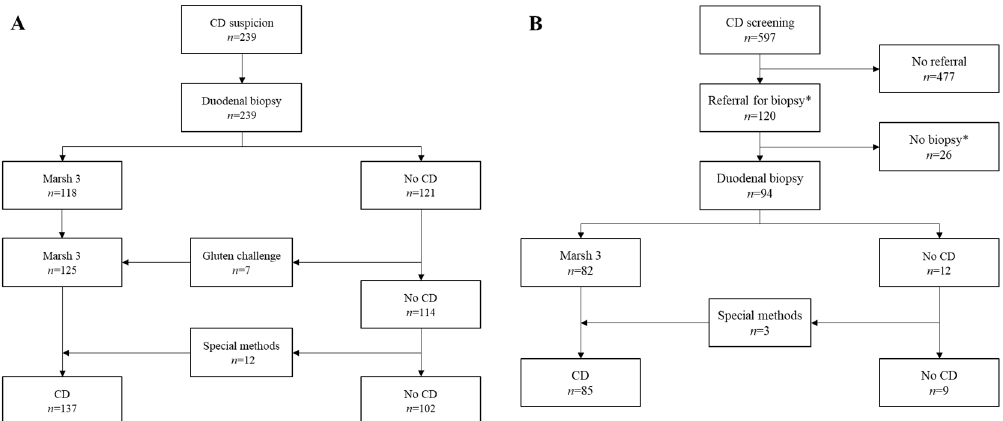
Figure 1. Flowchart of the study. Clinical cohort ( A ) comprises subjects referred from primary care due to suspicion celiac disease (CD). All cases underwent duodenal sampling. Some of the patients with inconclusive histology received the diagnosis in a re-biopsy after one year (“Gluten challenge”). In a subset, the diagnosis was set on the basis of special investigations and clinical, serological, and histological response to gluten-free diet (“Special methods”). The family cohort ( B ) includes subjects with ≥ 1 relative with celiac disease. Only seropositive subjects were referred for further investigations. *Refusal, self-initiated gluten reduction, and exitus before